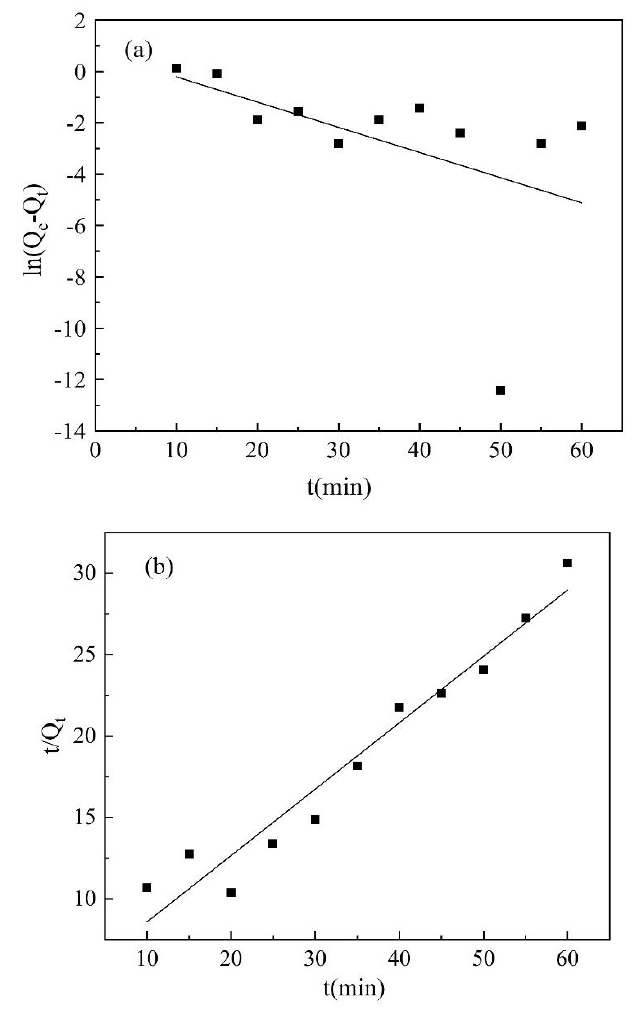
Figure 7. Adsorption kinetics. ( a ) Fitting curve of the quasi-first order kinetic equation. ( b ) Fitting curve of the quasi-second-order kinetic equation. Table 2. Fitting parameters of the kinetic equations.